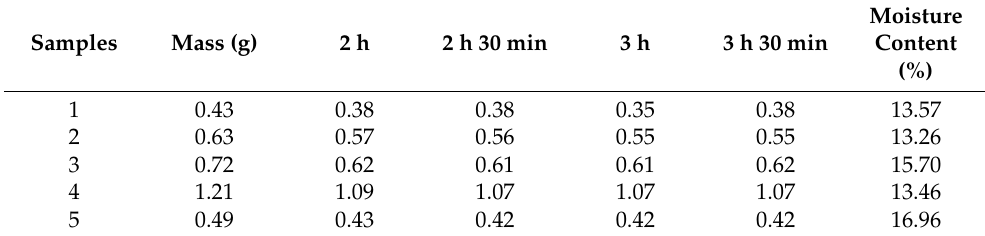
Table 3. Moisture content percentage of sedge fibers samples.